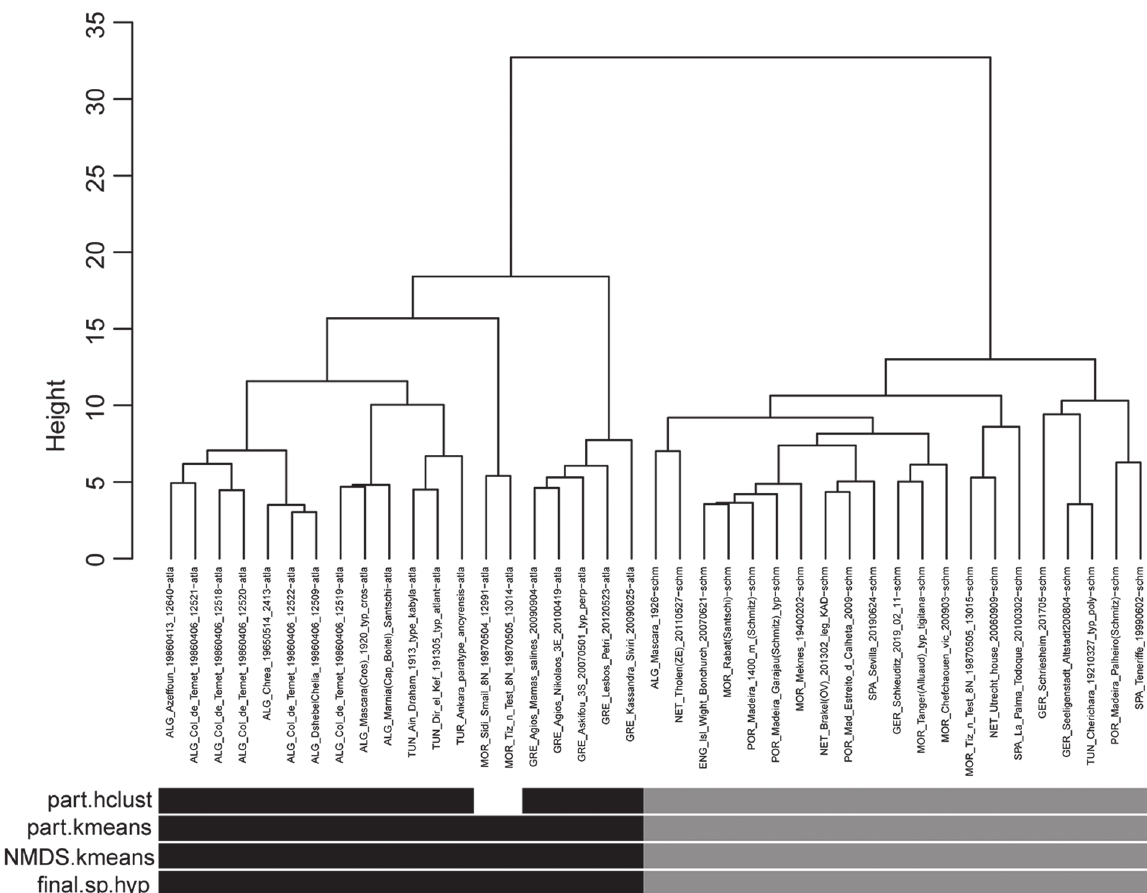
Figure 5. Results of four variants of NC-clustering: NC-Ward (hierarchical, tree shown), NC-part.hclust (hierarchical), NC-part. kmeans (iterative vector-quantisation), NC-NMDS (non-metric scaling) ; 21 nest samples of Plagiolepis schmitzii (grey bars) and of 20 nest samples of Pl. atlantis (black bars). Outliers in NC-part.hclust are given by the white